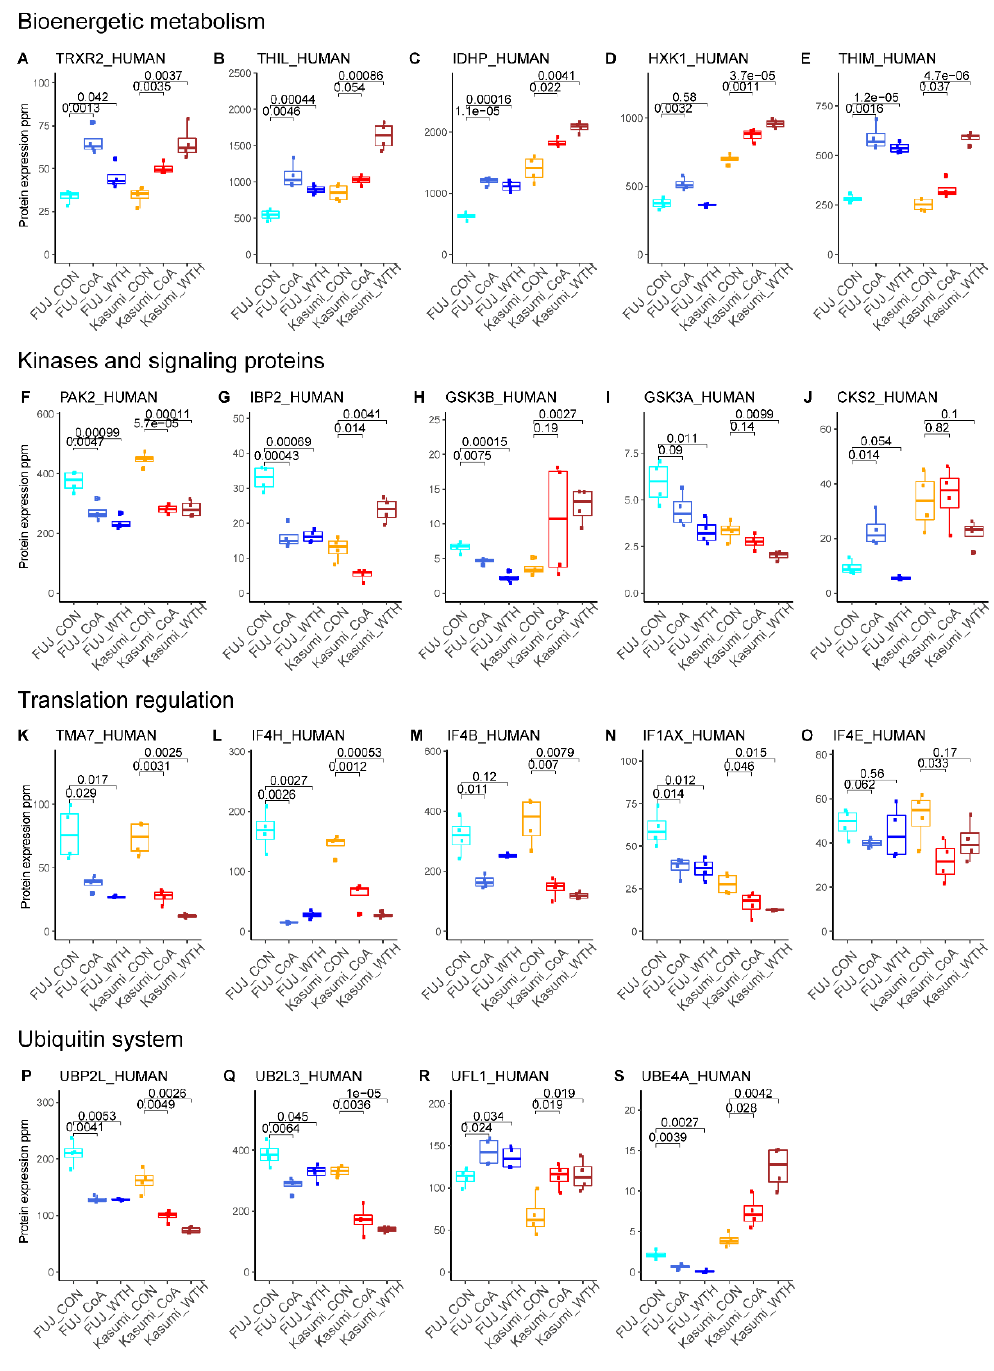
Figure 4. Withanolides produce changes in expression of proteins with key roles in cell biology. Shown are a selection of proteins with roles in bioenergetic metabolism ( A–E ), kinase signaling ( F–J ), translation ( K–O ) and the ubiquitin system ( P–S ). Numbers linking conditions denote p -values obtained by t -test ( n = 4). Data points showing treatments to P31-Fuj are shown in shades of blue; treatments to Kasumi-1 cell lines are known in shades of red/brown.